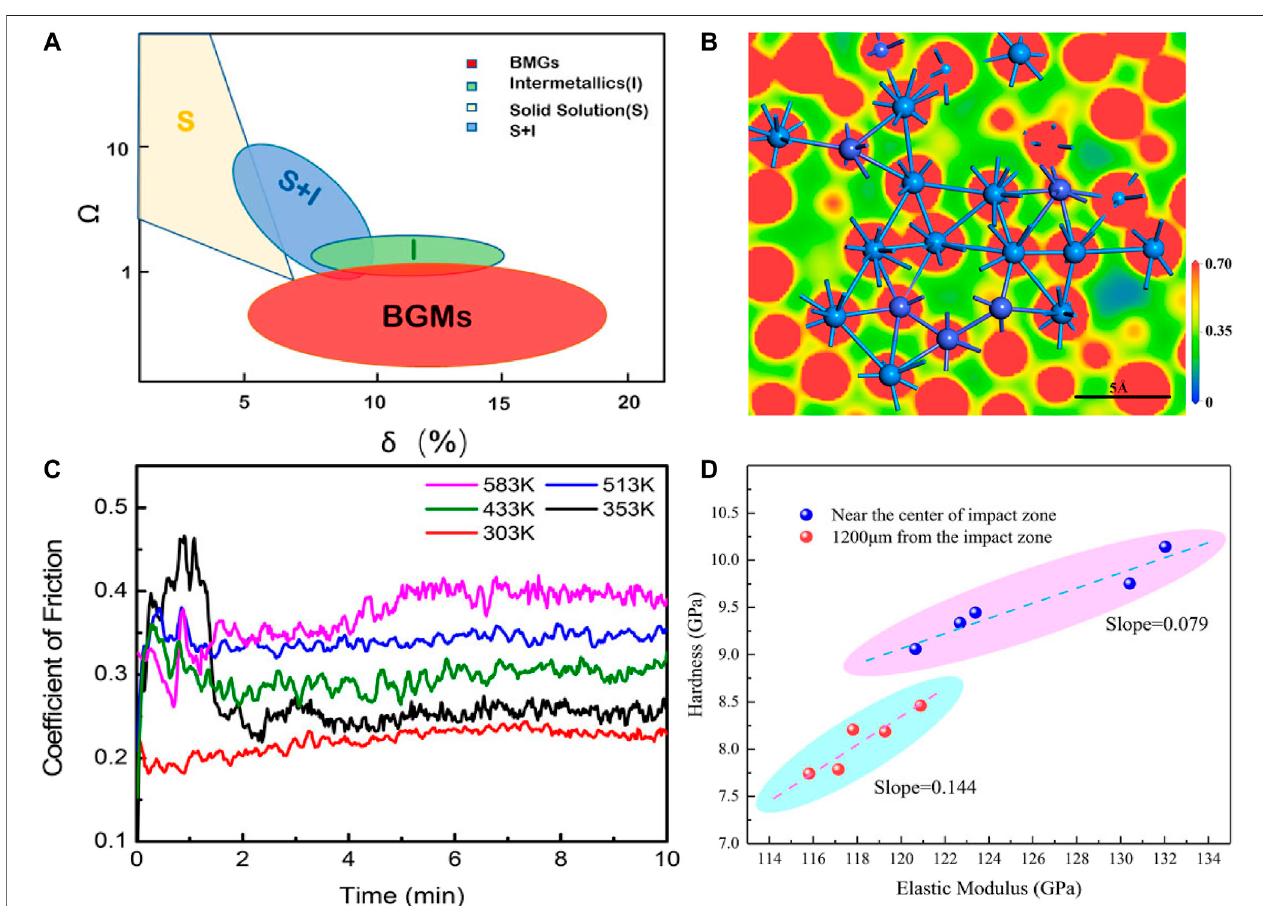
FIGURE 1 | (A) Relationship between the parameters Ω and δ of multicomponent alloys and the amorphous phase region, (B) the slice map of electron density of U-Co melts, (C) the coef fi cient of friction of the Ti-based BMG sample tested at different temperatures with an applied load of 3.5 N, and (D) the hardness as a function of the elastic modulus of samples after laser shock